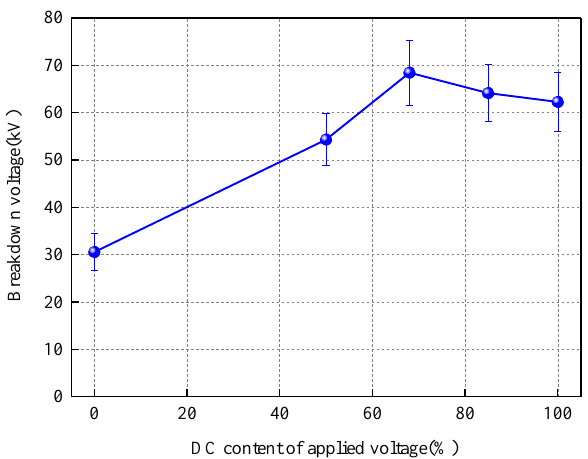
Figure 6. Breakdown voltage of oil-pressboard insulation under AC-DC combined voltage.